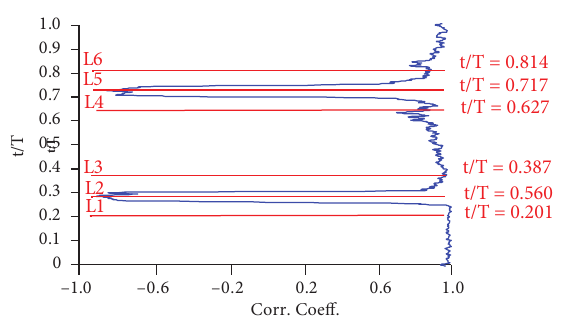
Figure 19. Coefficient of linear correlation between sensors S7 and